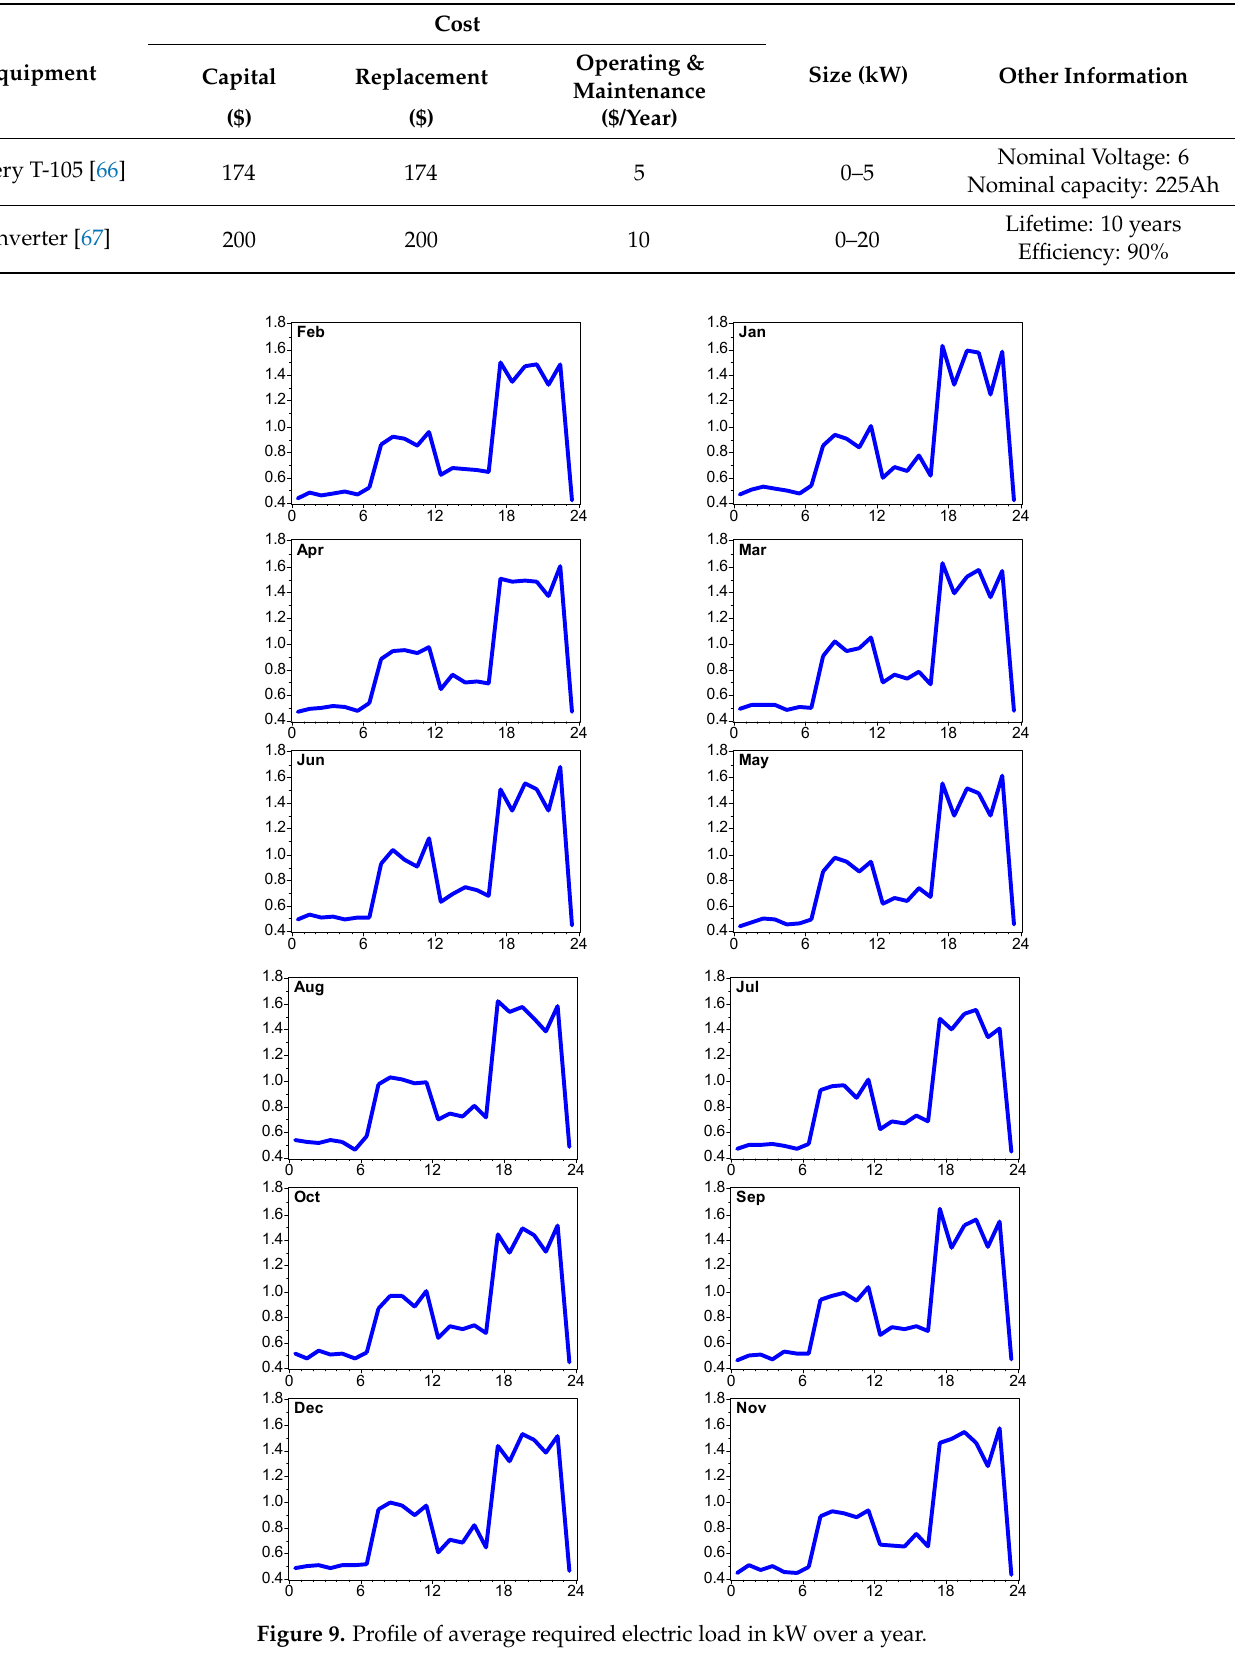
Table 3. Cont. Figure 8. Schematic of the simulated system.